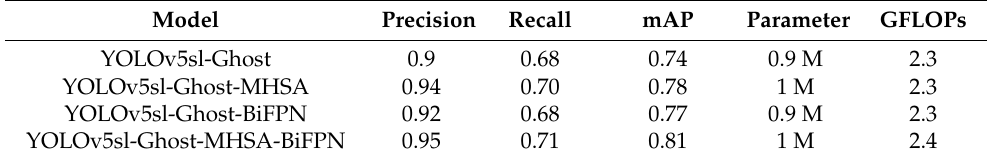
Table 2. Ablation study on spacecraft dataset.